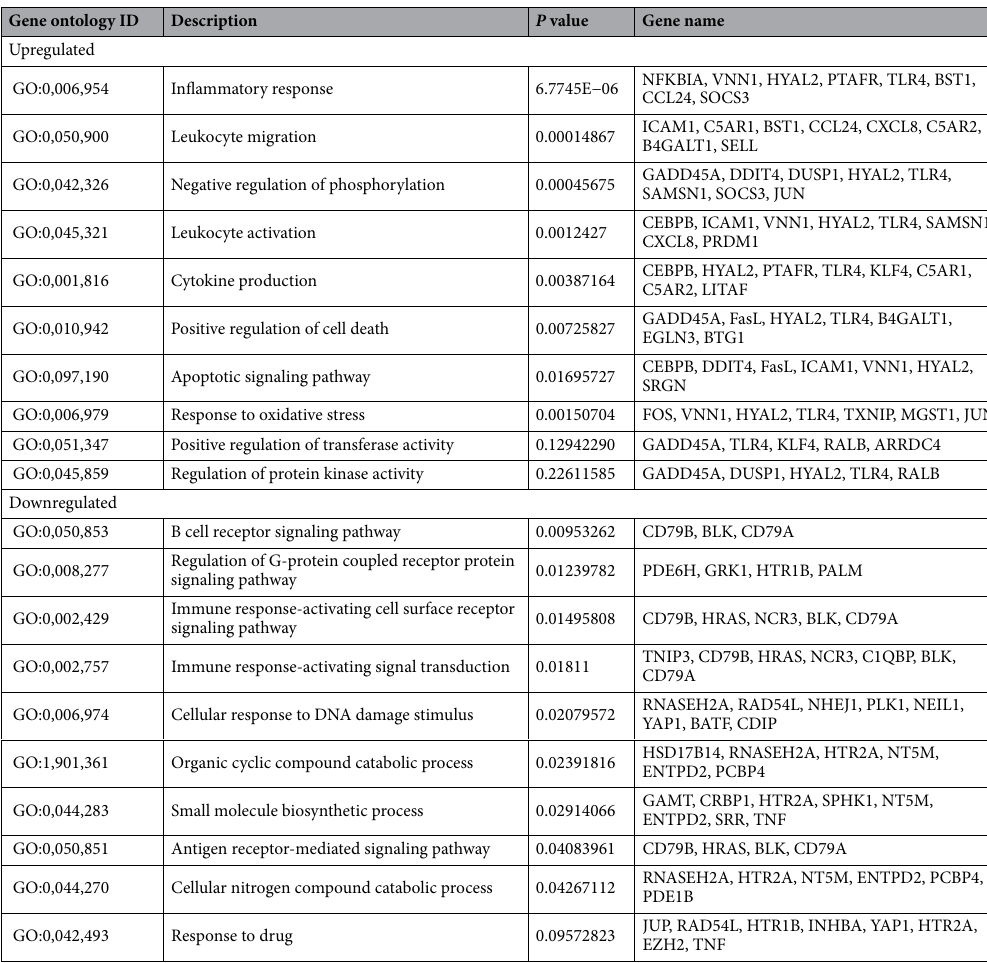
Table 5. Upregulated and downregulated biological processes in blood samples of goats transported for 30 min vs. goats not transported